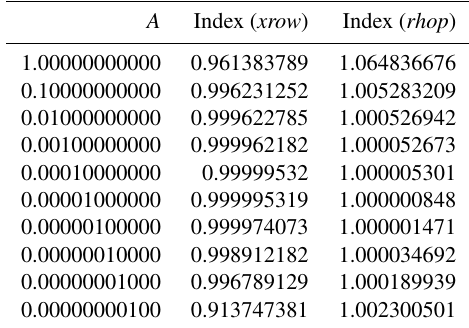
Table 1. Validation results of the tangent linear